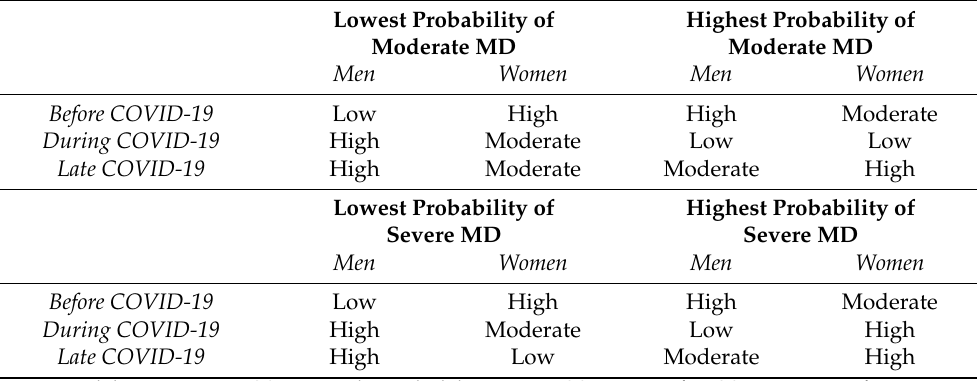
Table 13. Predictive probabilities of moderate and severe mental distress levels by physical exercise frequency and COVID-19 era during weekends among men and